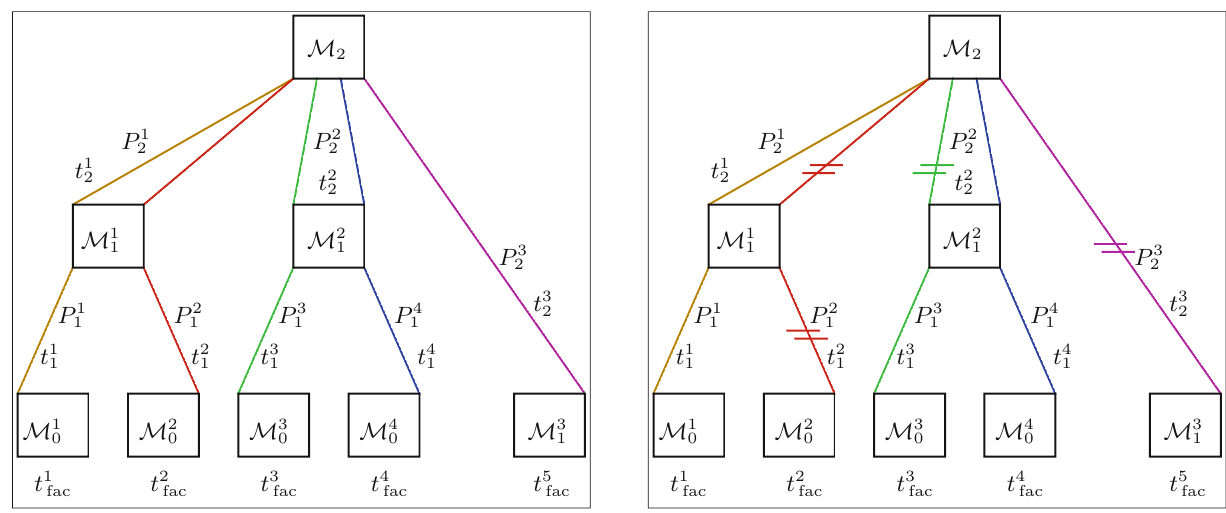
(b) The red and purple paths do not contribute, and the green path only contributes indirectly to the state M 2 . Fig. 1 History pyramid to illustrate different levels of contribution to the MOPS factor. The superscripts are numbering the different nodes. We use the shorthands M X ≡ | M ((cid:2) X ) | 2 , t X ≡ t ( (cid:2) X /(cid:2) X − 1 ) , and P X ≡ P ( (cid:2) X /(cid:2) X − 1 ) . The top layer is the main + 2-particle state and the lower boxes represent the clustered states after one and two successive clusterings, respectively. The scales and splitting probabilities associated with the clusterings are noted along the lines. For illustrative purposes we included a path where the Born state is reached after one clustering ( purple line ), as present e.g. when combining QCD and electroweak